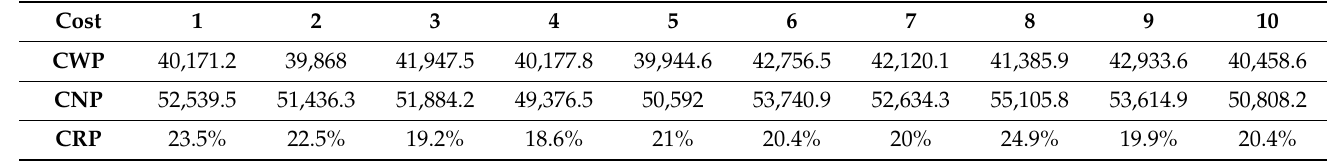
Table 2. Computational results of the first instances set in Case